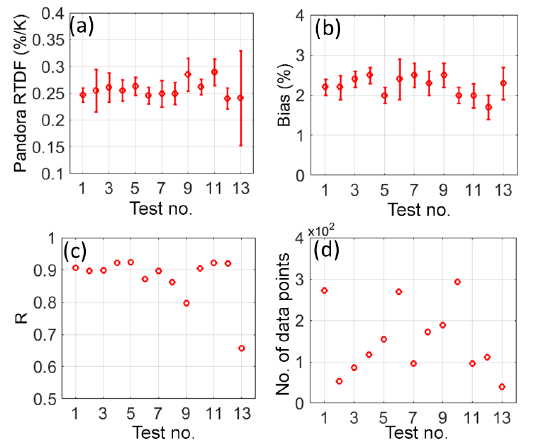
Figure 7. Pandora relative temperature dependence factors derived from 13 sensitivity tests (shown in Table 3). (a) RTDFs, (b) multi- plicative biases, (c) correlation coefficients ( R ), and (d) number of data points in sensitivity tests. The error bars show the 95% confi- dence